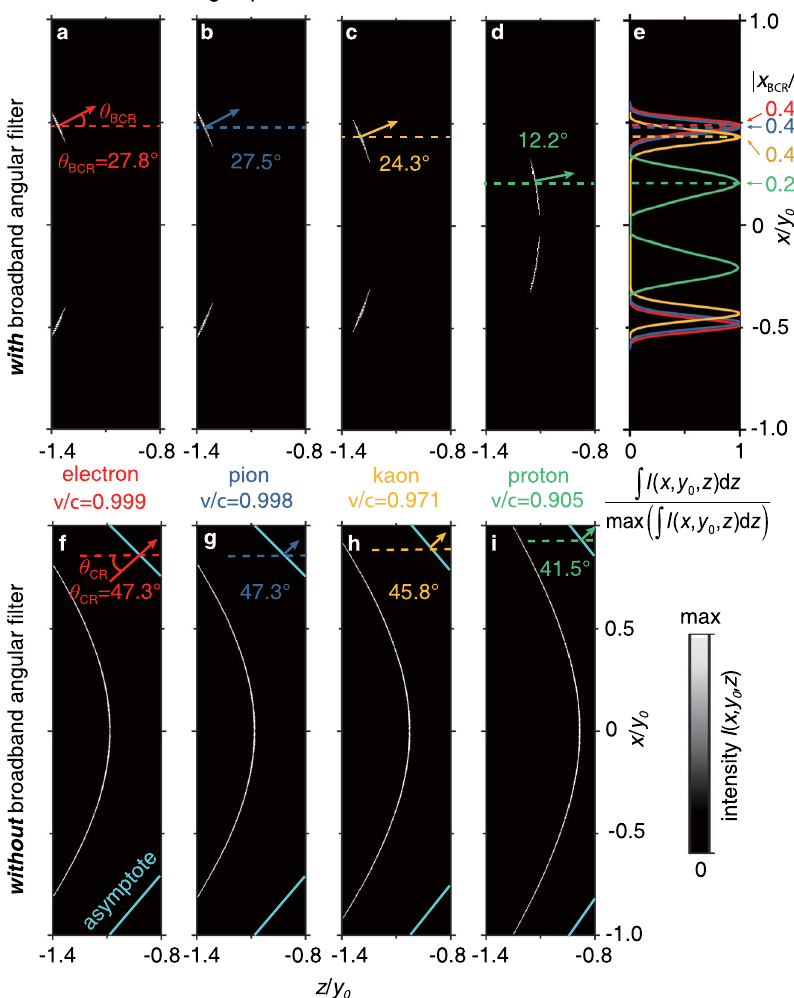
Fig. 2 Cherenkov radiation in the detection plane of Brewster-Cherenkov detectors. Here we plot the intensity distribution of Cherenkov radiation for four elementary charged particles with a fi xed momentum, when these charged particles arrive at z = 0. a – e The Brewster-Cherenkov detector has the broadband angular fi lter [Fig. 1]. f – i For comparison, the angular fi lter is removed. The Cherenkov radiation in ( a – d ) is related to the pseudo Brewster- Cherenkov angle θ BCR , whose value can be obtained through the measurement of the peak-intensity position in ( e ), while the asymptotic line of Cherenkov radiation in ( f – i ) is related to the regular Cherenkov angle θ CR . Our proposed approach has no critical requirement on the permittivity of the host material in which the charged particle is traveling (e.g., ε h = ε r1 used in the calculation). Here and below, the considered wavelength varies from 400 to 700 nm. In addition, y 0 = 2.3 mm, ε r1 = 2.18, and n BCR = generality, we choose n BCR = 1.13 and y 0 = 2.3 mm, and plot in (cid:3) (cid:3) (cid:3) (cid:3) (cid:3) (cid:3) as a function of momentum for the four Fig. 4b the ratio x BCR y 0 elementary particles. At the fi xed momentum of 2 GeV/ c , the (cid:3) (cid:3) (cid:3) (cid:3) (cid:3) (cid:3) gradually varies from 0.49, 0.48, 0.43 to 0.22 for ratio x BCR y 0